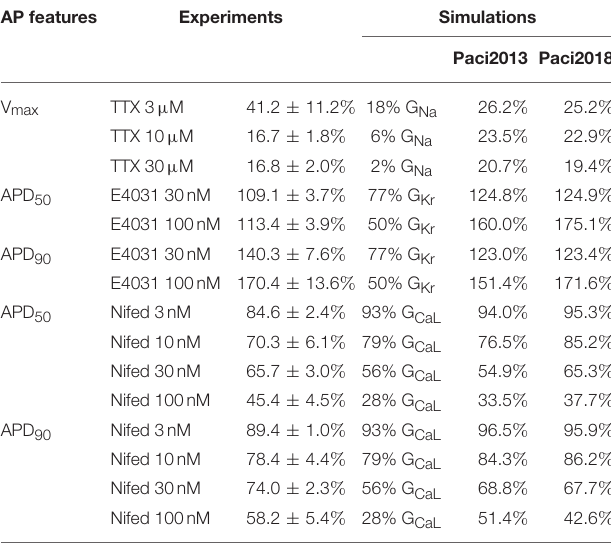
TABLE 3 | Quantitative effects of current blockers on stimulated